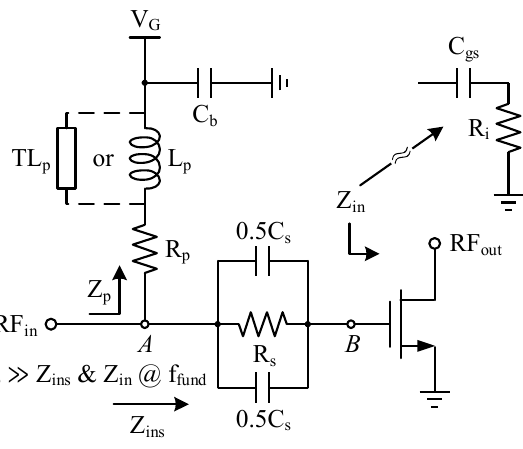
Figure 2. Schematic of the stabilized transistor.